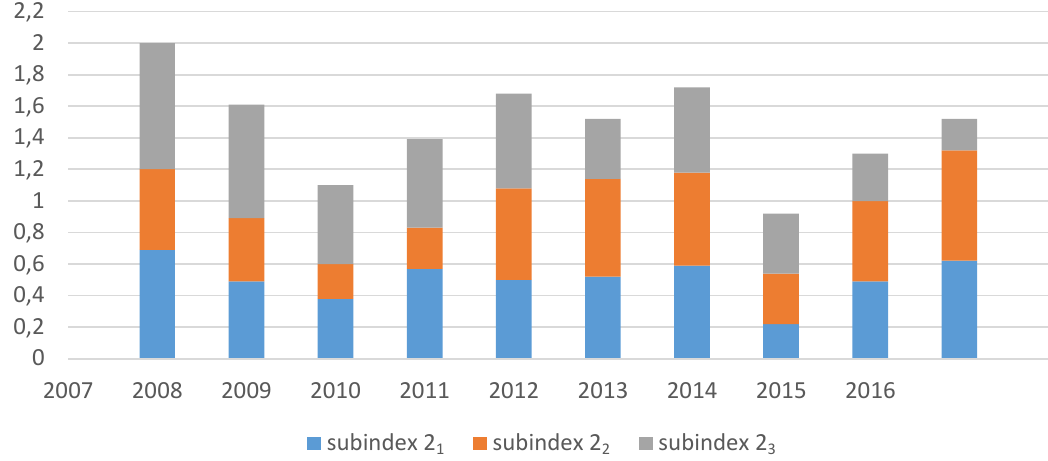
Figure 4. Dynamics of changes in values of sub-index components of the effective implementation of the Ukrainian banking system functions for